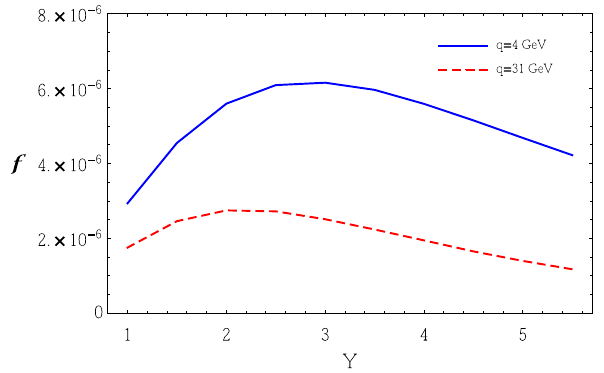
Fig. 8 Energy dependence of f for q = 4 GeV (blue continuous line) and q = 31 GeV (red dashed line) for the closed spin chain